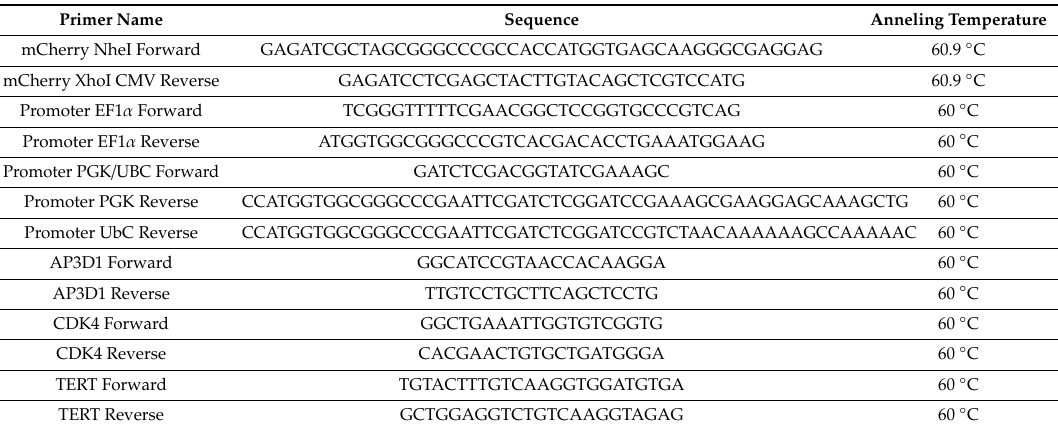
Table 1. Primers used for PCR